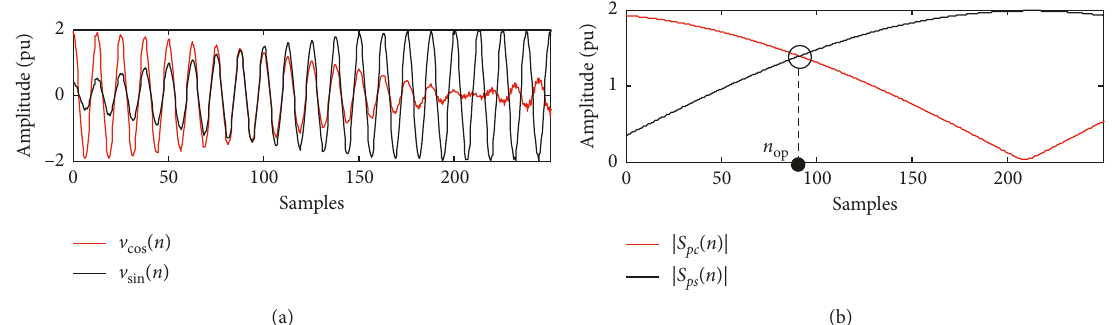
Figure 4: n selection case 1: (a) original signals; (b) PFCST results of signals in (a). op